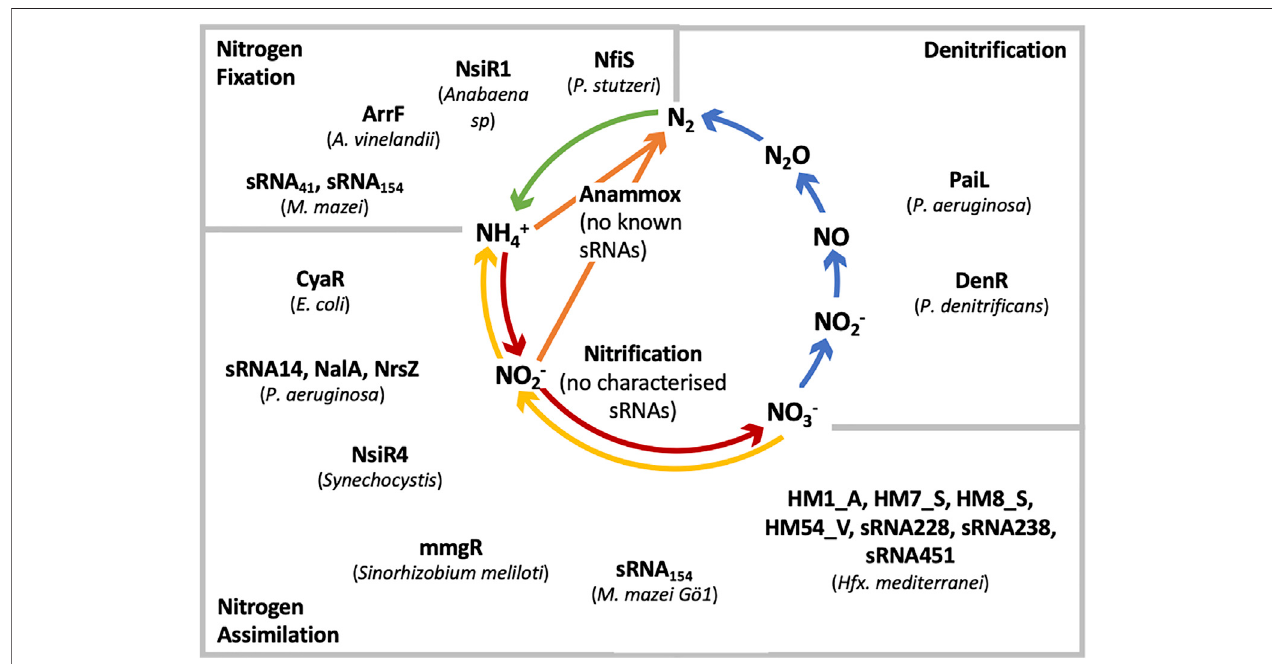
FIGURE3| MicroorganismsandknownsRNAsthatregulatethenitrogencycle.ThesRNAsaregroupedintotheprocessesofnitrogen fi xation,assimilatorynitrate reduction and denitri fi cation.